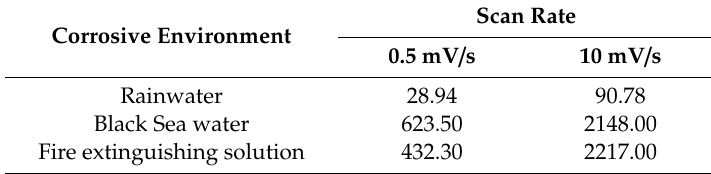
Table 12. Comparison between corrosion rates (v cor -in µ m / year) for the III-Mn sample. Corrosive